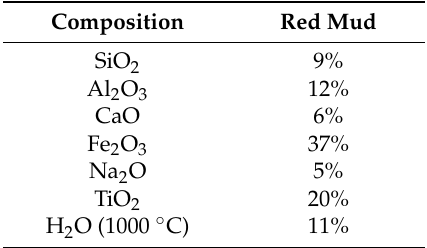
Table 1. Chemical composition of red mud (weight basis) [40].